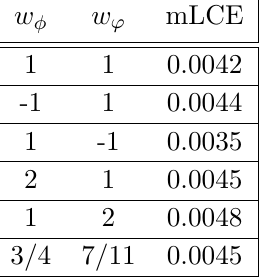
Table 2 . mLCE for ˜ κ = ˜ β = 0 integrated for T = 1600 with initial conditions p θ (0) = 3 / 10 ,